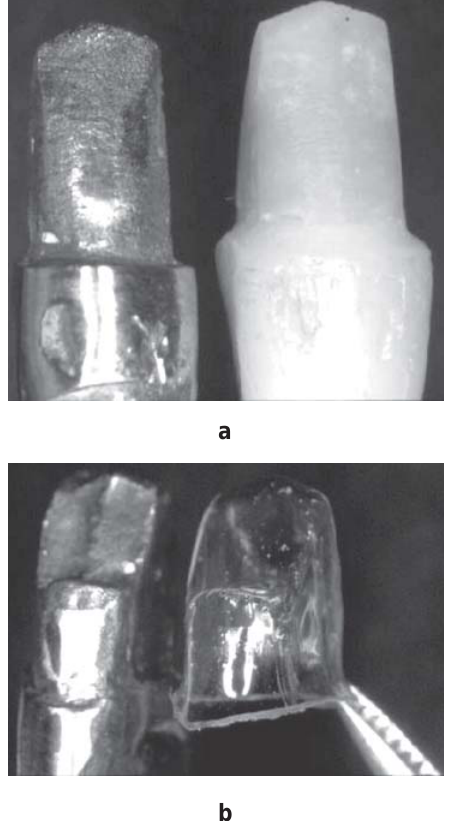
FIGURE 1- Construction of acetate molds